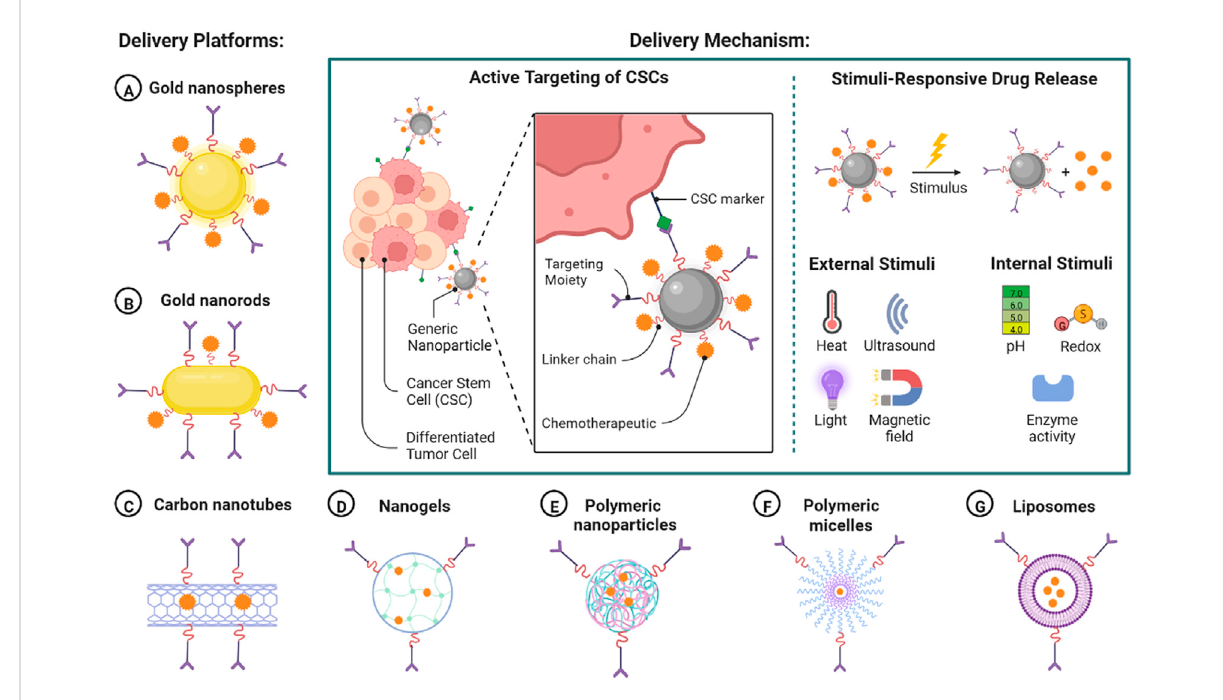
Nanoparticle-mediated targeted drug delivery to cancer stem cells (CSCs).